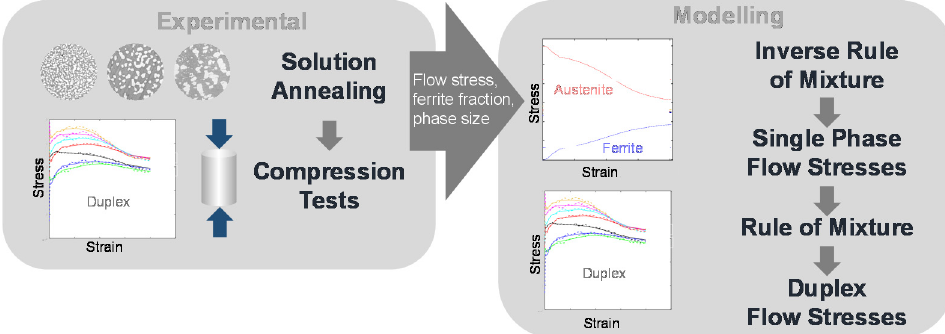
Figure 1. Schematic overview of the used characterisation and modelling techniques to investigate the influence of microstructure to flow stress of duplex steels within the present work. Table 1. Steel composition in weight percent, measured by spectral